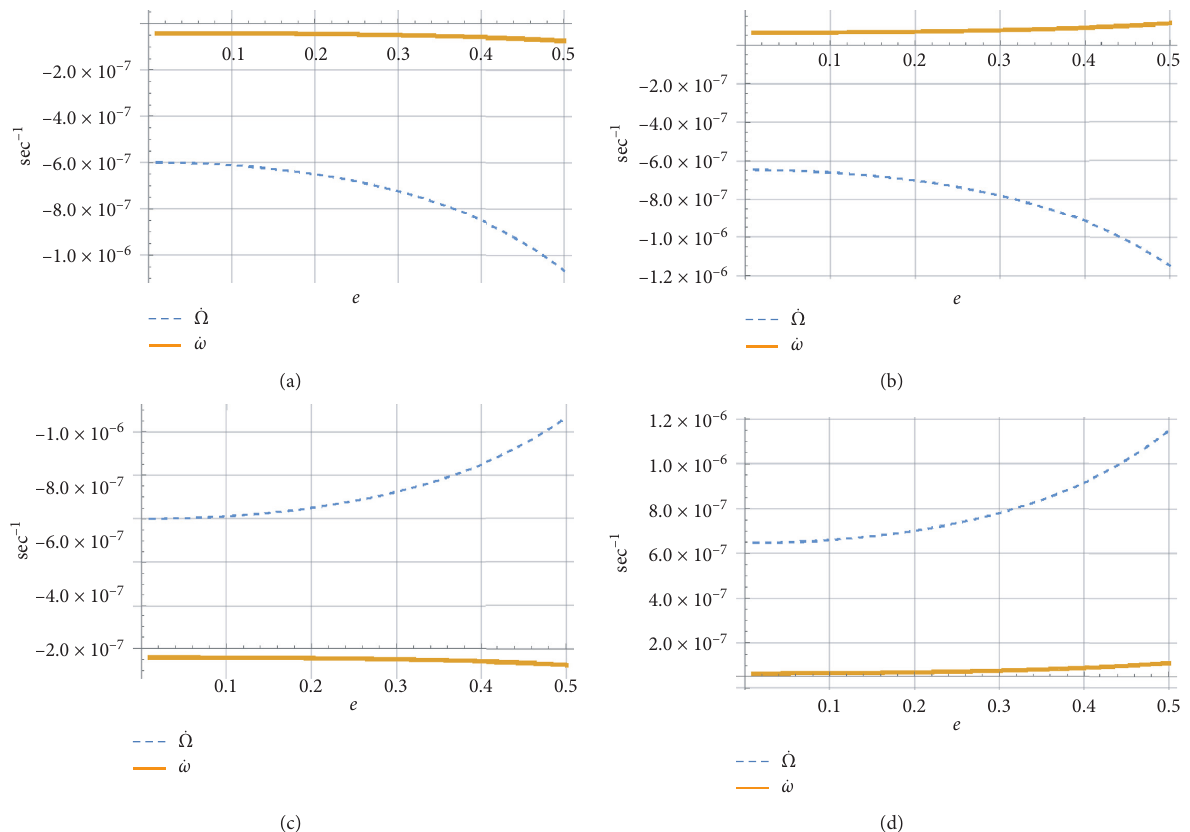
Figure 6: Curves of _ Ω and _ ω with e for the 4 cases corresponding to F ( i ) � 0.05. (a) i � 64 . 27, (b) i � − 62 . 11, (c) i � 115 . 73, and (d) i � − 117 .